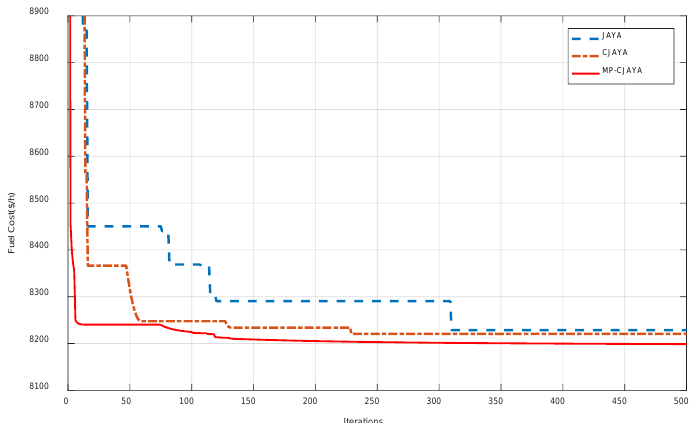
Figure 2. Fuel cost convergence characteristic of 3-units system ( P D = 850 MW).